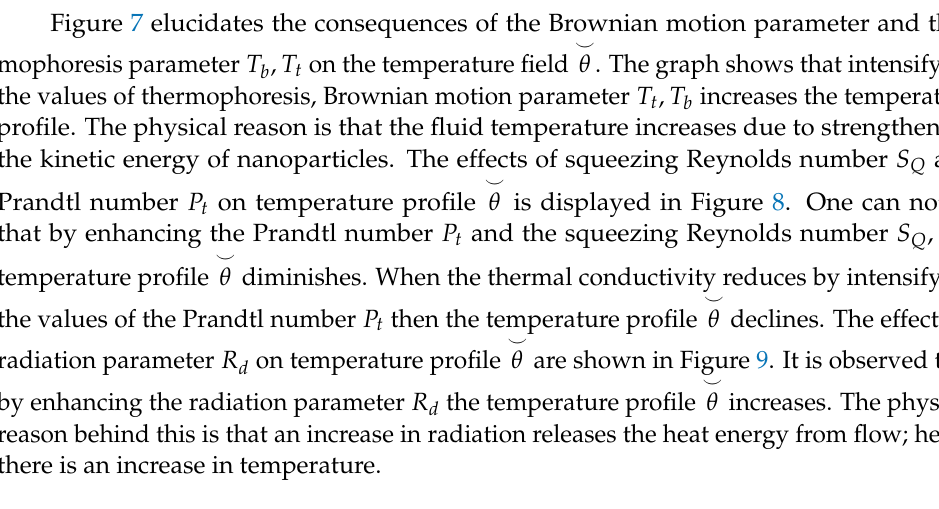
Figure 6. Implications of Re M on m ( λ ) , n ( λ ) in axial and tangential direction.